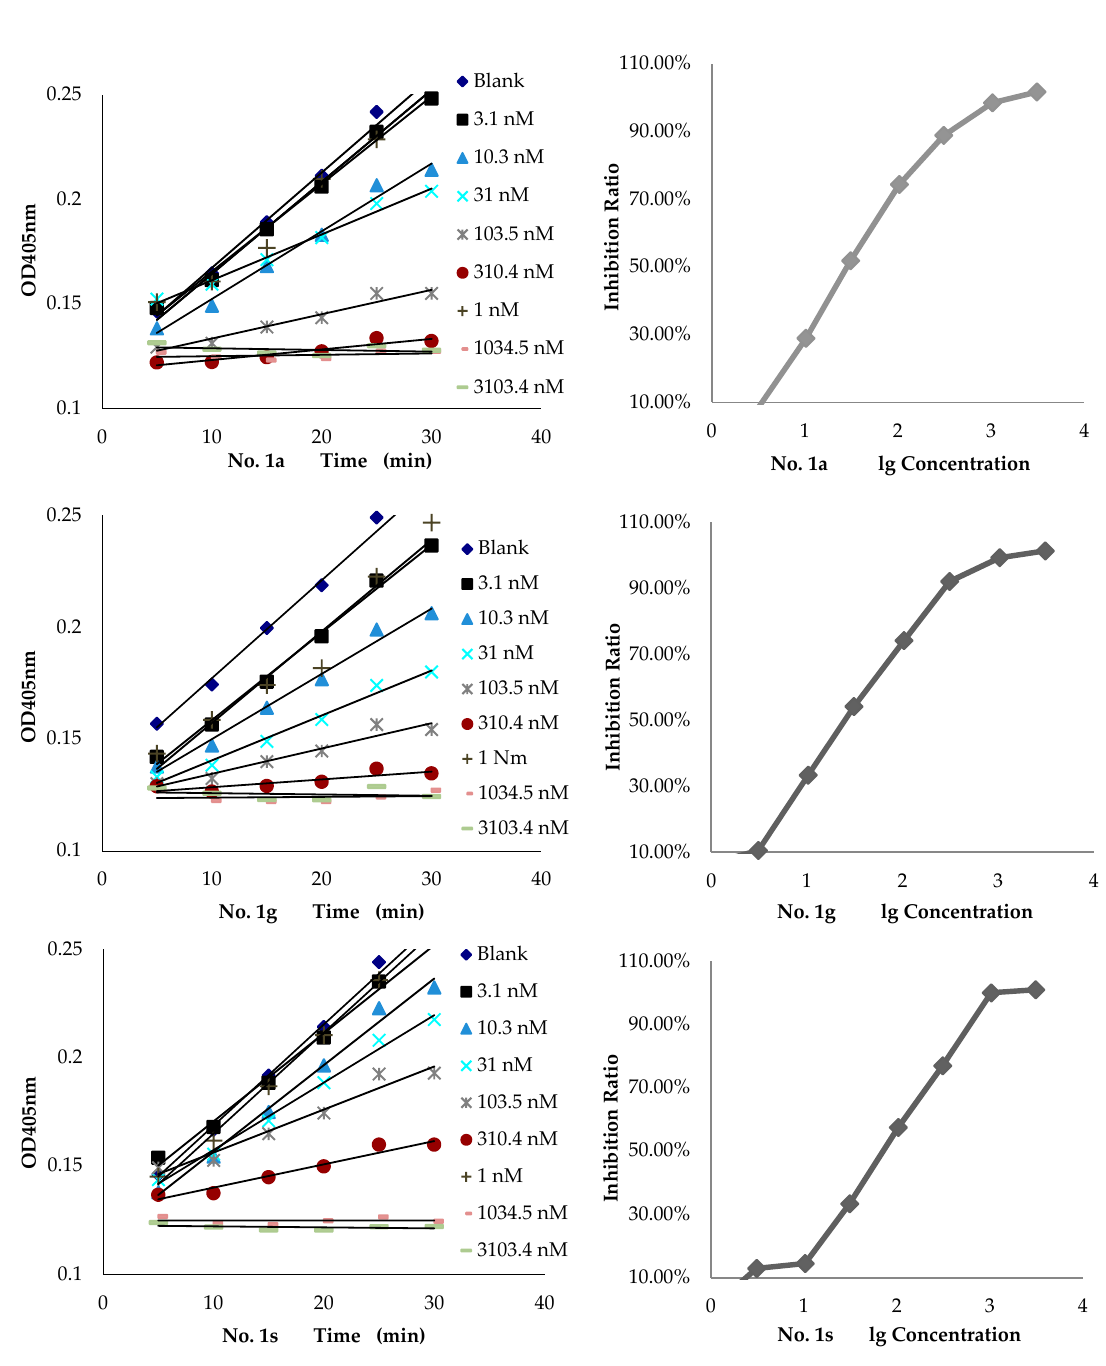
Figure 5. The inhibition profile figures of 1a , 1g and 1s